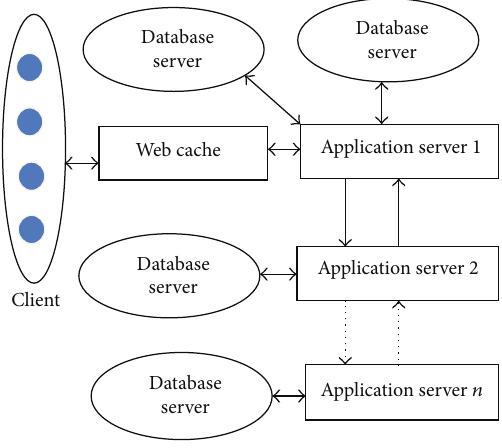
Figure 2: Distributed database